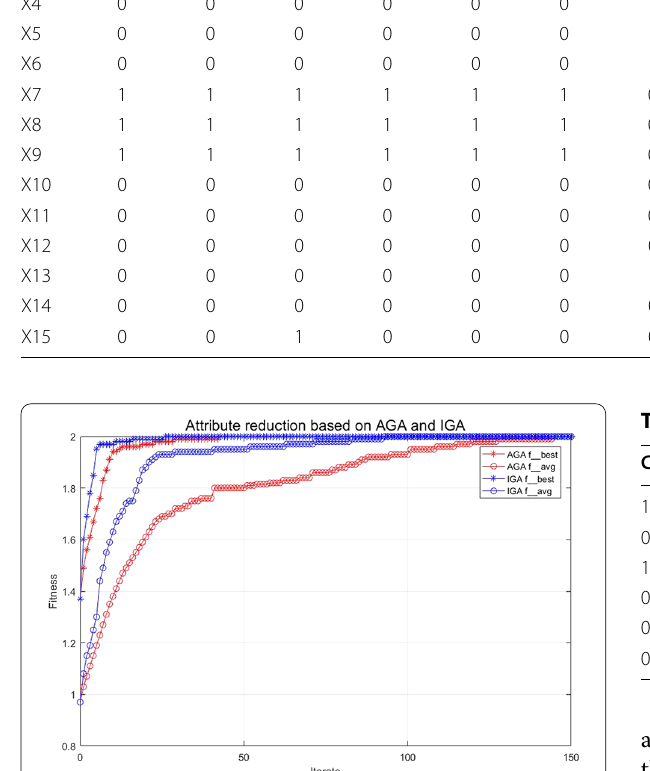
In Figure 7, the red “*” curve represents the optimal value searching iteration process of the adaptive genetic algorithm. The red “o” curve represents the average value obtained by searching through the iteration process of the adaptive genetic algorithm. The blue “*” curve repre- sents the optimal value searching iteration process of the improved genetic algorithm. The blue “o” curve repre- sents the average value searching iteration process of the improved genetic algorithm.